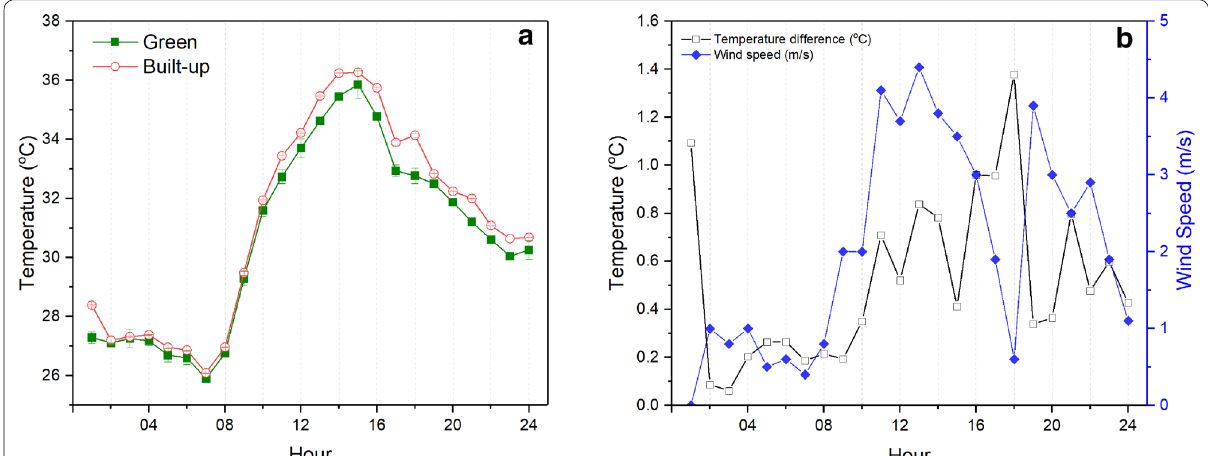
Fig. 8 a Diurnal variation of model output for air temperatures in green and two built‑up locations (average of two locations of the same land‑use category), b relationship between wind speed and temperature difference between built‑up and green areas